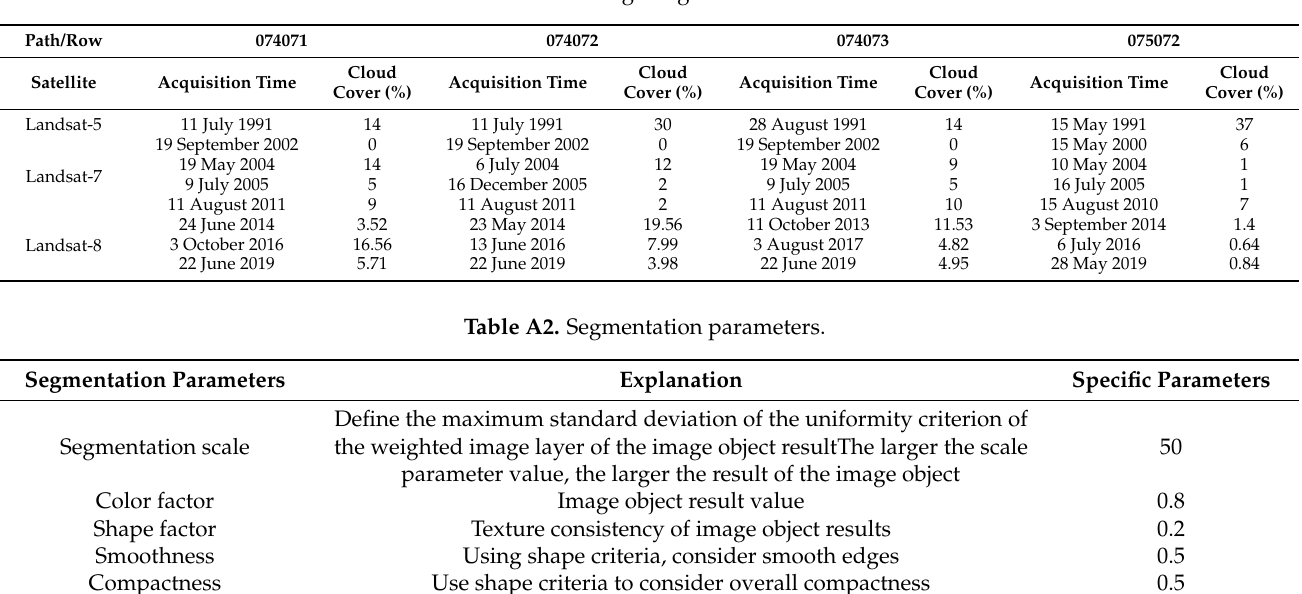
Table A1. Remote-sensing image detailed information.